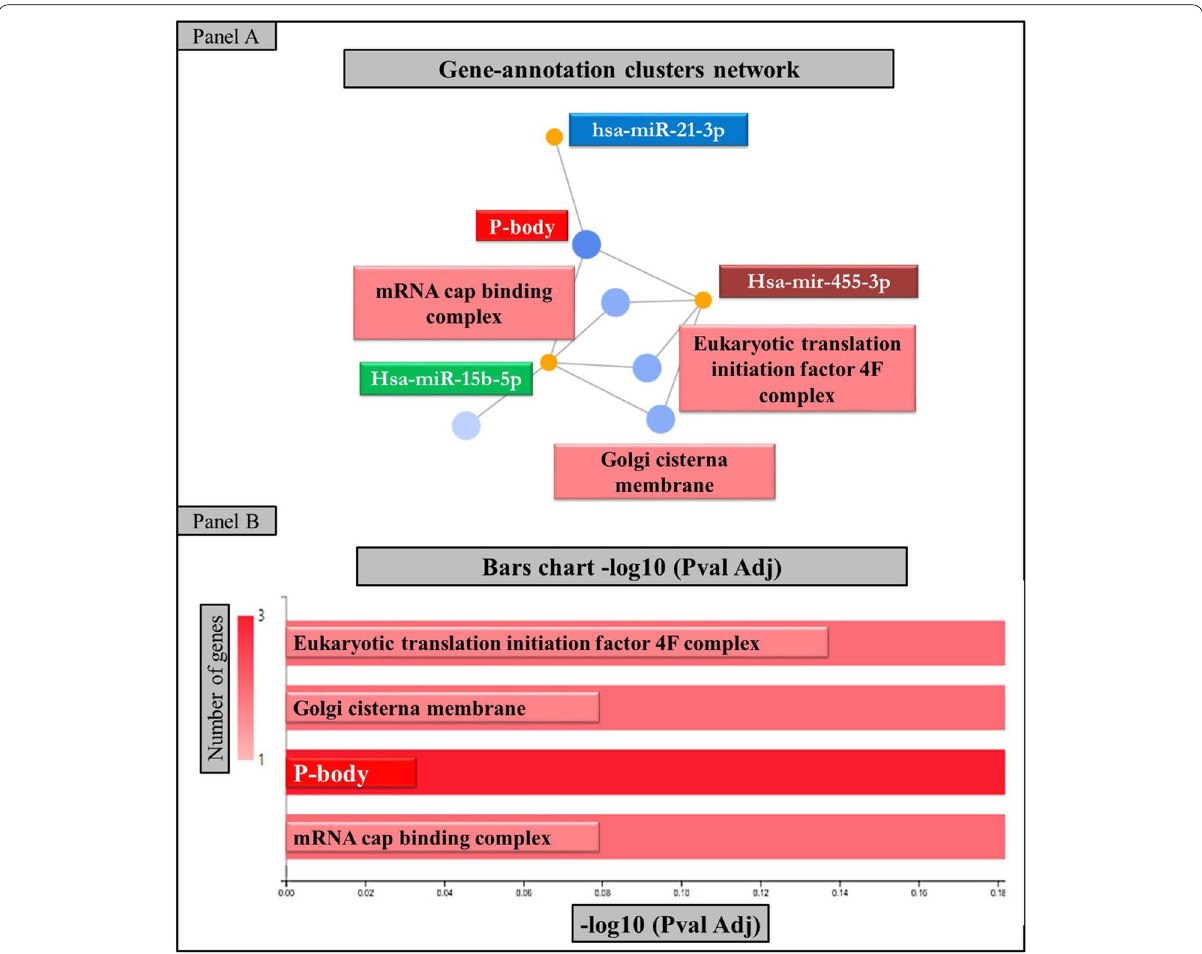
Fig. 3 GeneCodis4 provided the network plots and bar chart results. Co-annotation and enrichment network plot ( A ). Only three miRNA interact with each other with a primary cytoplasmic localization as part of cytoplasmic ribonucleoprotein granules processing bodies, according to GeneCodis4 analysis of all 39 miRNA interactions (P-bodies). Each bar’s length corresponds to the annotations found to agree with the color intensity ( B